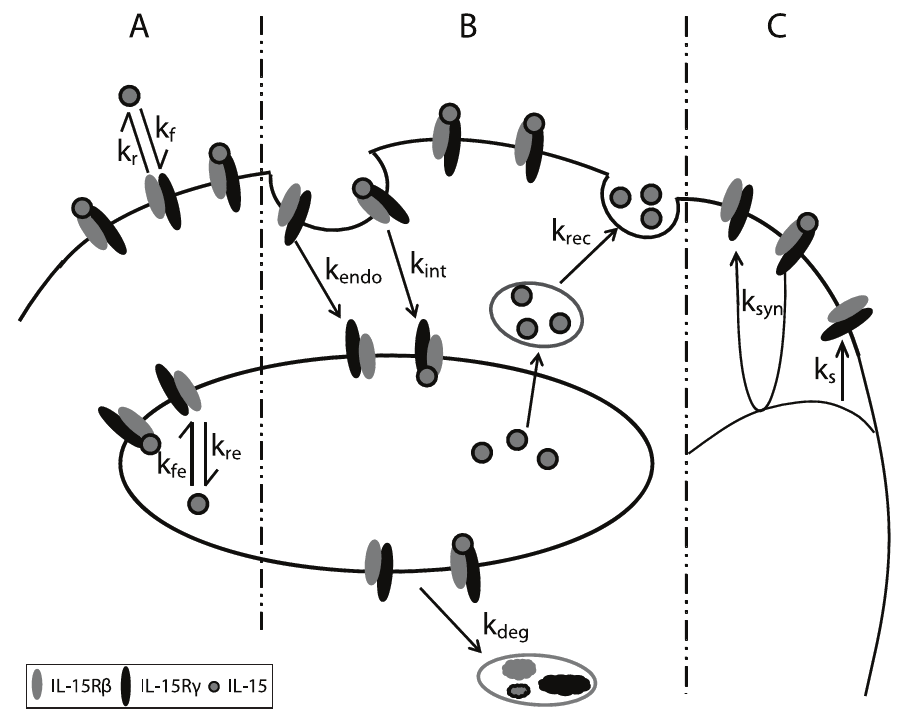
Figure 1. Representative diagram of intermediate affinity IL-15 receptor binding, trafficking and synthesis interactions. Quiescent NK cells constitutively express the b and c subunits of IL-15R. A . Binding: IL-15 binds to receptors on the cell surface with rate k f and dissociate from IL-15R with rate k r . Inside the endosome, the on and off rates k fe and k re reflect modified binding affinity at lower pH. B . Trafficking: Free IL-15 receptors are constitutively internalized with rate k endo , and the ligand bound receptor complexes are internalized with rate k int . The IL-15 ligand recycles from the endosome back to the surface with rate k rec , and the receptors and complexes are sorted for degradation with rate k deg . C . Synthesis: The IL-15R synthesis is constitutive with rate V s and can be induced ( k syn ) by signaling initiated by the surface complexes.